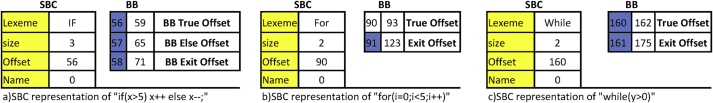
Example of flow control representation of ANSI C in SBC format.